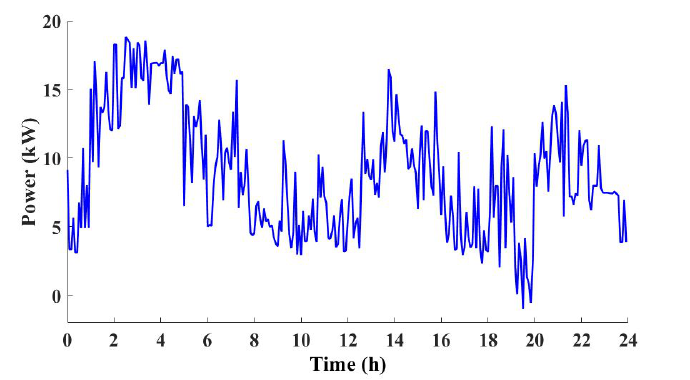
Figure 5. The net power state of the